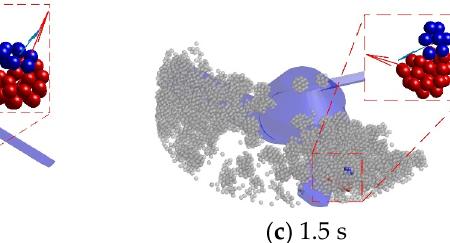
Figure 8. Particle average velocity between 0.5 s and ~2 s. The trajectory of the particles subjected to both types of breakage is depicted in Fig- ure 9. While the particles subjected to chopper action, which separates more and smaller particles, move at a slower rate toward the top of the granulation chamber and separate from larger particles, they accelerate under the action of the chopper and migrate to a higher position in the chamber.